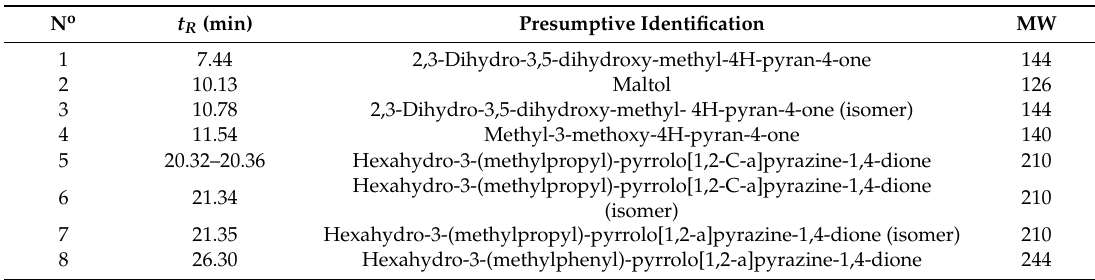
Figure 6. Chromatogram of the biotransformation products of Trametes elegans (EBB-046) obtained after an 80-h incubation period. Table 3. Biotransformation products of Trametes elegans